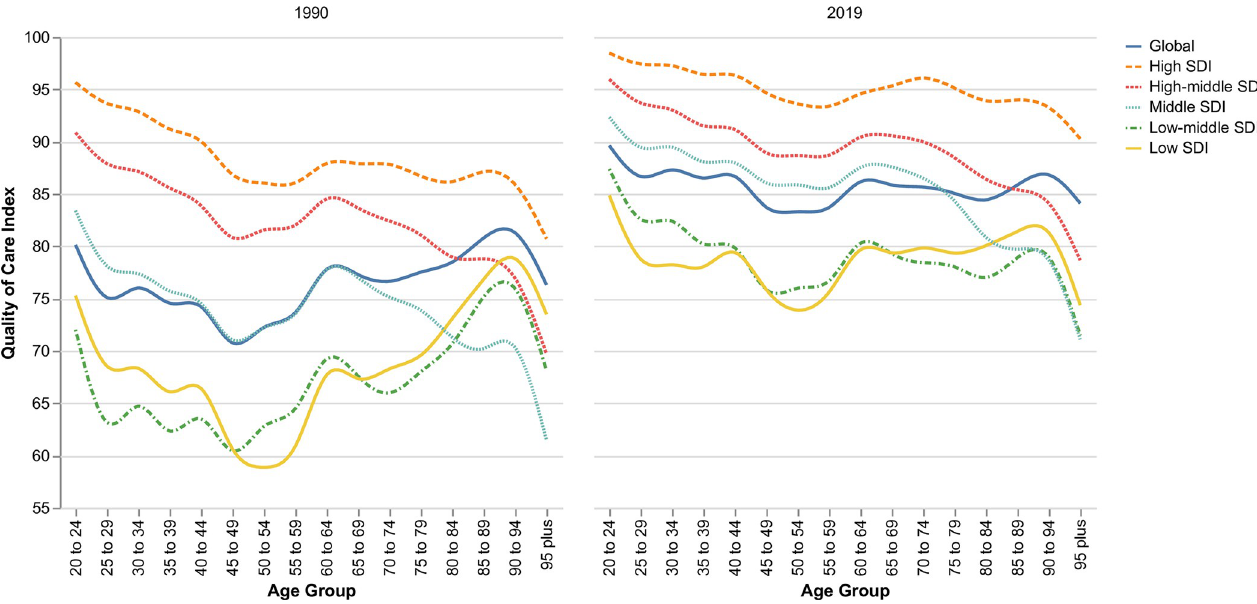
Fig 3. Age pattern for quality of care index based on SDI in 1990 and 2019.